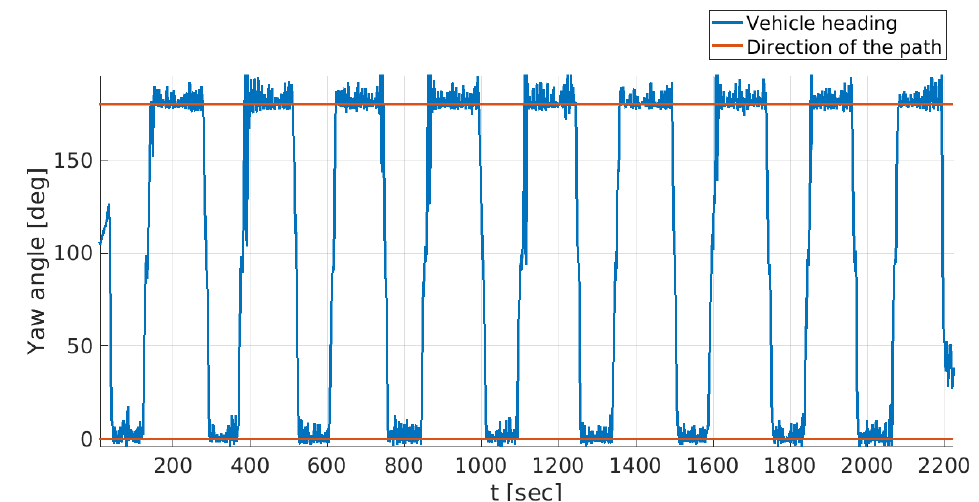
Figure 28. Vehicle’s heading during the mission, employing the ALICE configuration. The direction of the survey transects was defined from/to North to/from South